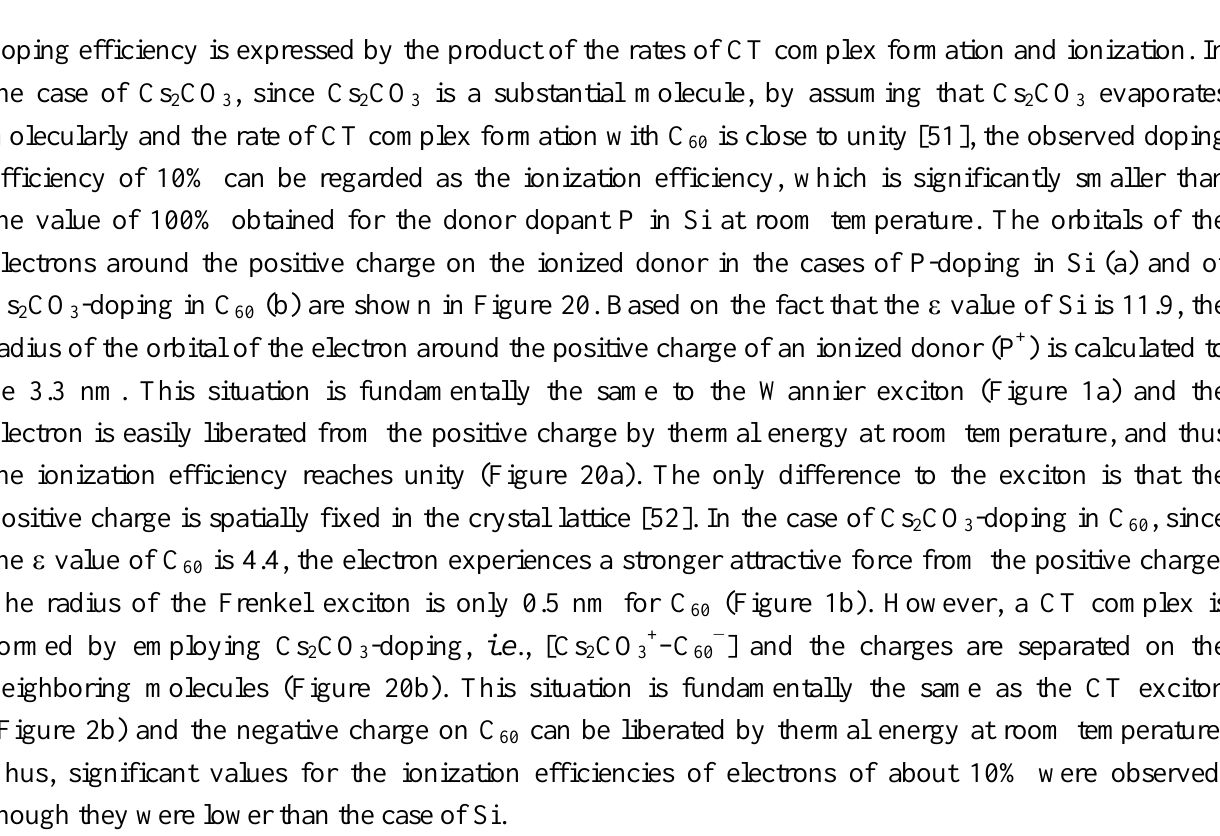
Figure 20. Orbital of an electron around a positive charge on an ionized donor. ( a ) P-doping in Si. P + is represented by the red shaded circle. This situation resembles the Wannier exciton (Figure 1a); ( b ) Cs shaded circle. This situation resembles the CT-exciton (Figure